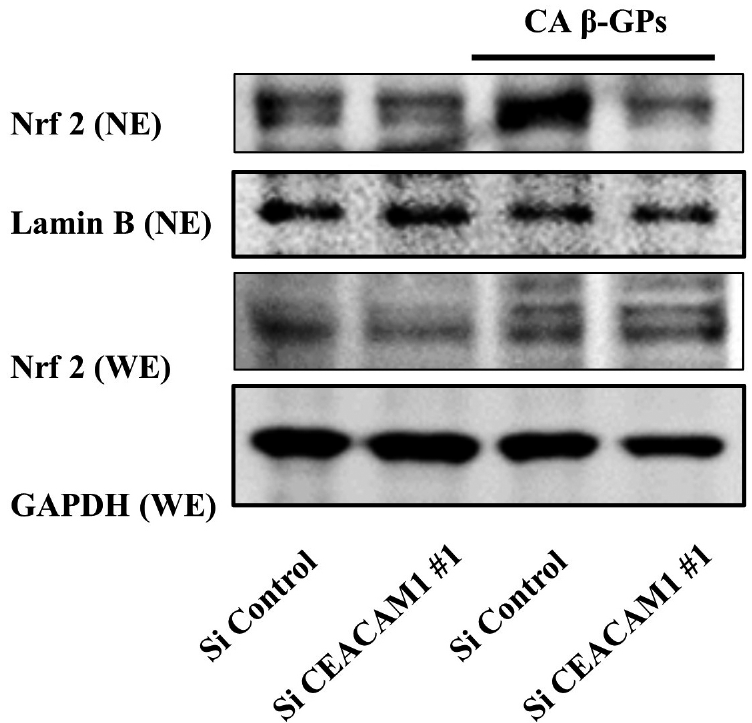
Figure 9- Effects of knockdown of CEACAM1 on β-GPs-induced translocation of Nrf2 into nucleus in RT7 cells Cells were transfected with siRNA for CEACAM1 siRNA for 48 hours, then stimulated with C. albicans β-glucan-containing particles (CA β-GPs) (200 μg/mL) for 4 hours. Whole cell and nuclear extractions were prepared, then subjected to western blot analysis with the Nrf2 antibody. LaminB and GAPDH were used as marker proteins for the nuclear and whole cell fractions, respectively. The experiments were performed at least three times, with representative results